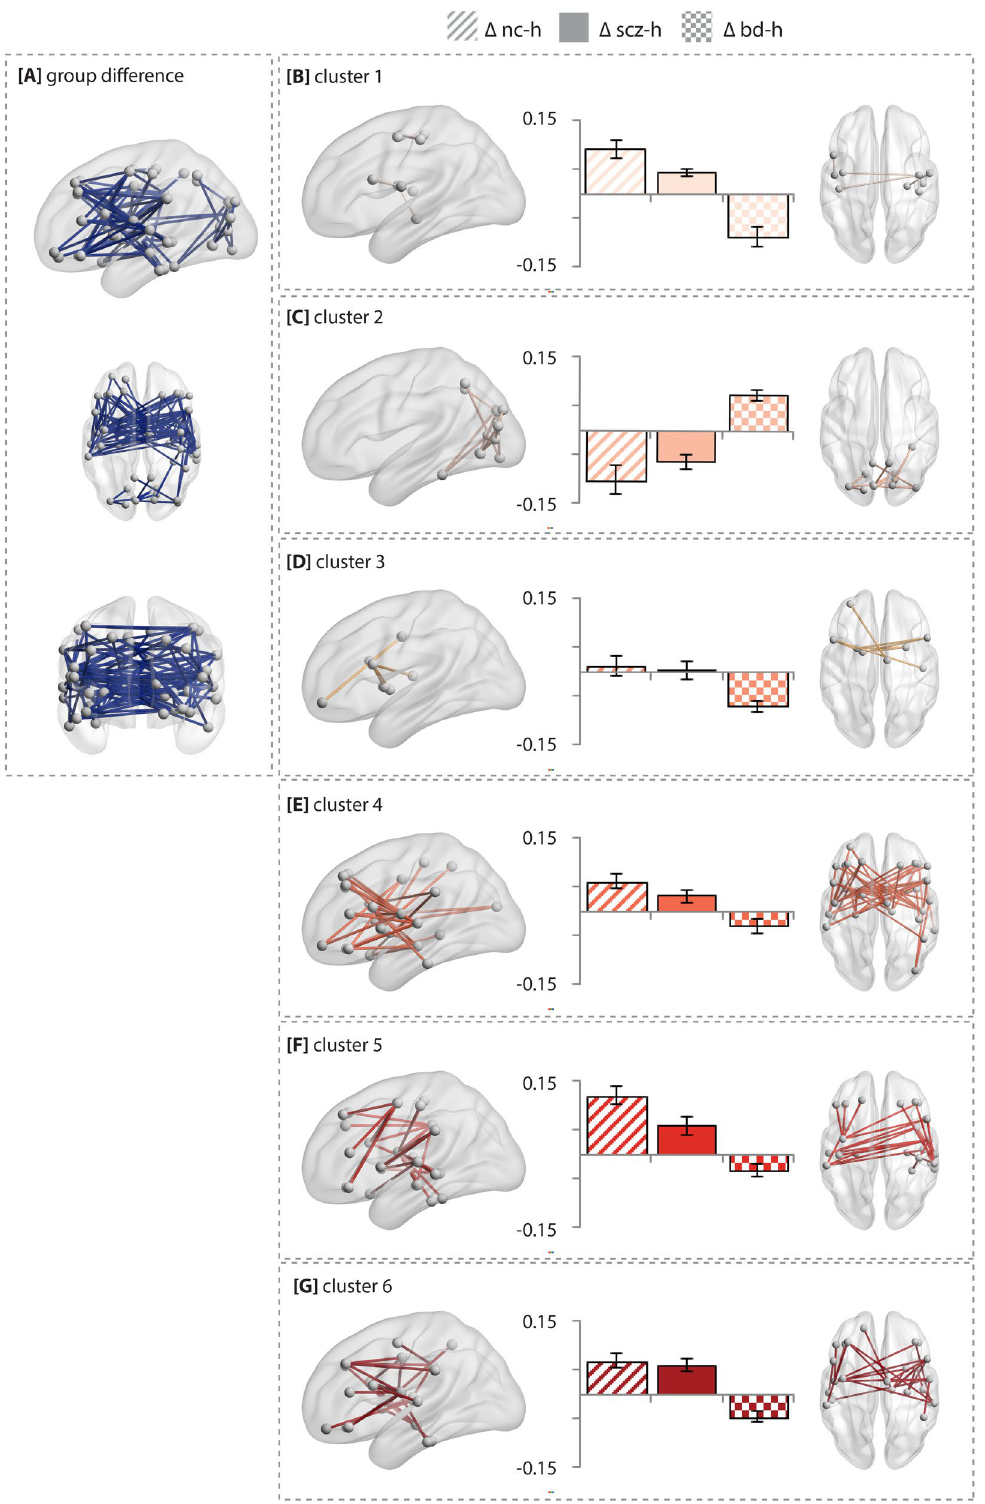
Figure 3. Sets of connections clustered according to their behavior in clinical and non-clinical individuals with hallucinations. ( A ) The result of the overall group comparison between patients with schizophrenia (n = 99), patients with bipolar-I disorder with (n = 74) and non-clinical individuals with hallucinations (n = 40) using the AAL atlas. ( B–E ) the edges in the component that differed between the groups were clustered by a k-means clustering algorithm to elucidate differences across the groups with hallucinations. Error bars represent the standard deviation of connectivity strength within that particular cluster. The group differences were tested using an F-test at T = 8.0; P < 0.05 at 10,000 permutations. The test- statistics and AAL labels corresponding to the altered connections per cluster can be found in Supplementary Table 9. Age and sex were included as covariates. NC-H non-clinical individuals with hallucinations, BD-H bipolar-I disorder with lifetime history of hallucinations, SCZ-H schizophrenia spectrum disorder with